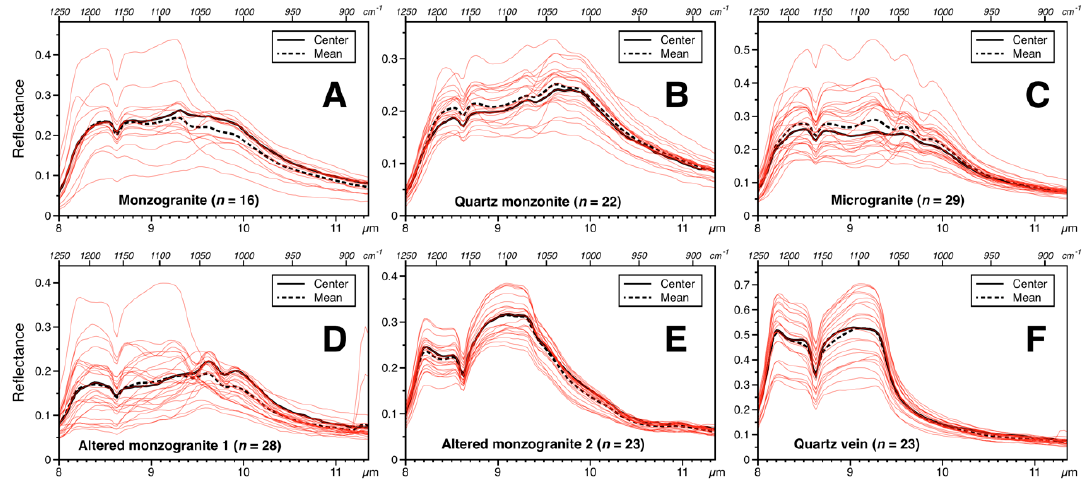
Figure 8. FTIR spectra of samples from the Naundorf quarry. ( A ) Monzogranite; ( B ) Quartz monzogranite; ( C ) Microgranite; ( D ) Altered monzogranite 1; ( E ) Altered monzogranite 2; ( F ) Quartz vein.